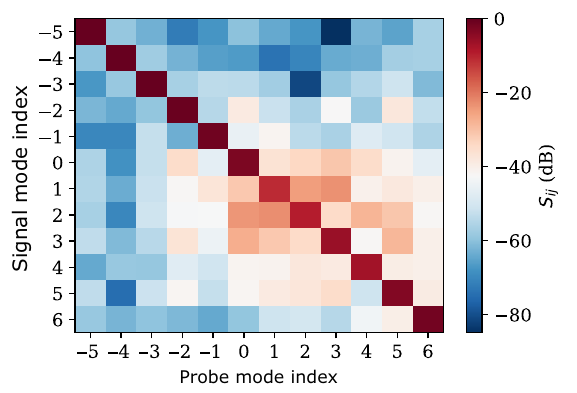
FIG. 15. Scattering matrix. Magnitude of scattering matrix elements measured with four pump tones. The mode indices are consistent with Fig. 4. The dB scale is referenced to the reflected amplitude in mode − 5.